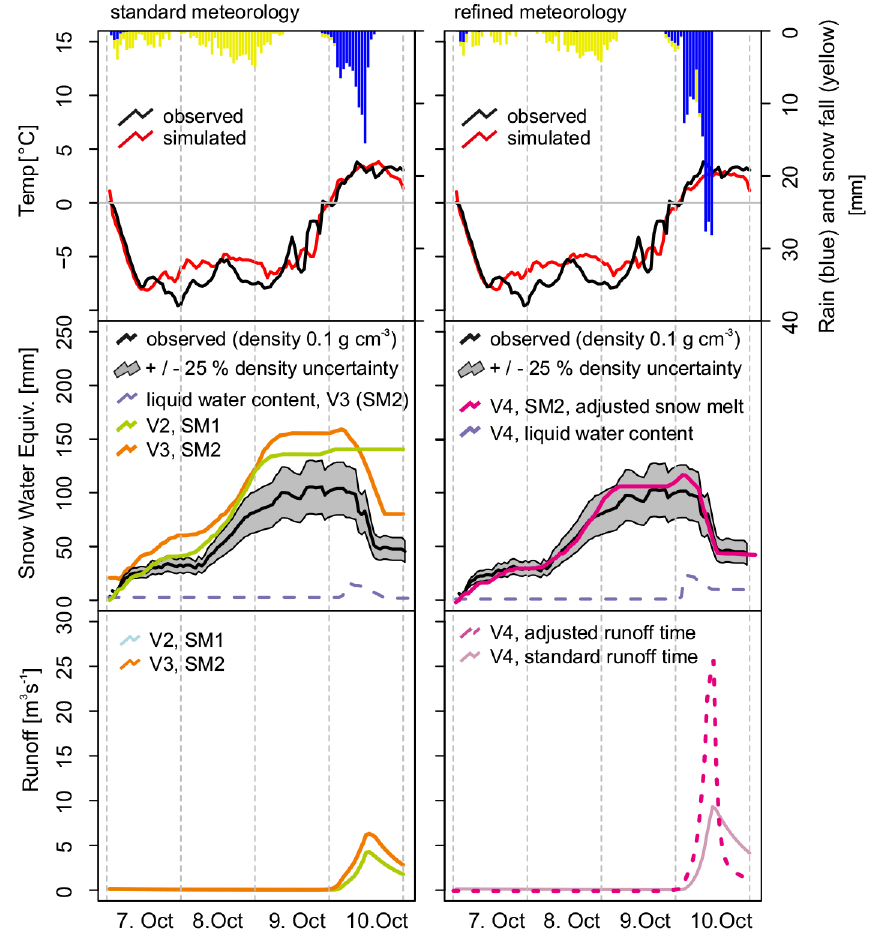
Figure 9. Model performances with standard and refined meteorology for precipitation and temperature (top row), snow depth (center row) and runoff (lower row) for the tributary river Milibach using both snow models (SM1 and SM2, model V2 and V3). Shaded grey area indicates the uncertainty origin from unknown snow density ( ± 25% of 0.1gcm − 3 ). Dashed violet line depicts the liquid water content in the snow cover. Refined meteorology and snowmelt from latent and sensible heat are able to reproduce both snow cover accumulation and